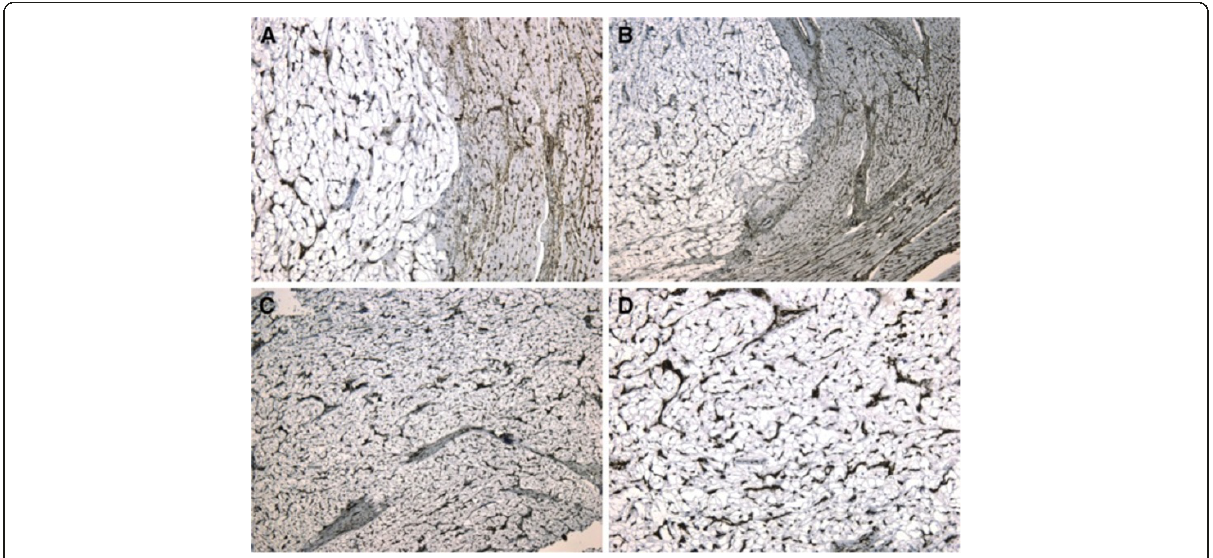
Figure 3 Microscopic findings. ( A - B ) Intense positive reaction of the tumoral fibers for antibodies anti-CD34 and anti-Vimentin ( C - D